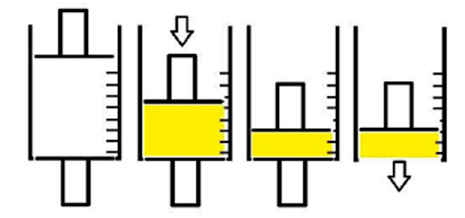
Figure 6. Schematic representation of the process to obtain the minitablets.